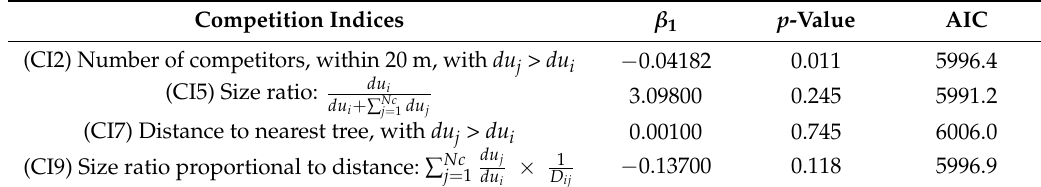
Table 2. List of competition indices tested, respective parameter estimates ( β 1 ), significance ( p -value), and Akaike information criterion (AIC) values, where ij is the distance between subject tree i and its competitor tree j; du is the diameter at breast height under cork; Nc is the number of